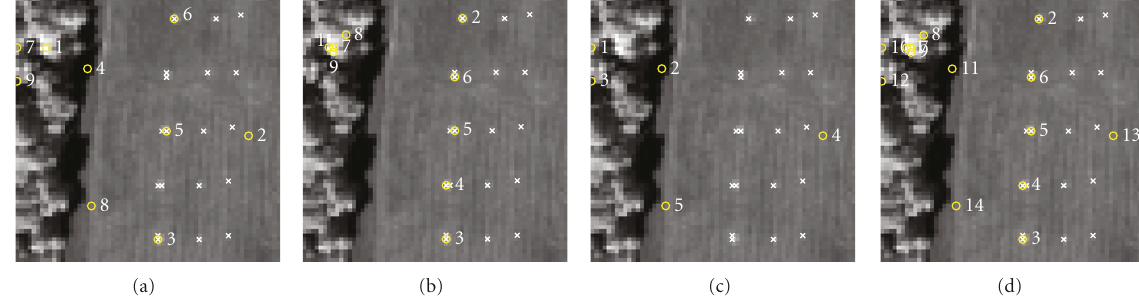
Figure 16: ATGP-generated BKG and target pixels (a) 9 BKG pixels in original data; (b) 9 target pixels in sphered data; (c) 5 BKG pixels not identified as target pixels; (d) 14 pixels obtained by combining the pixels in (b)–(c).